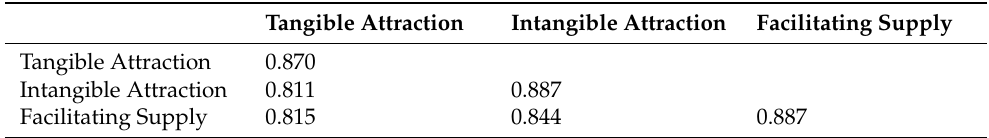
Table 6. Discriminant validity: Pearson correlation coefficient and squared root of average variance extracted (AVE) for experience quality.